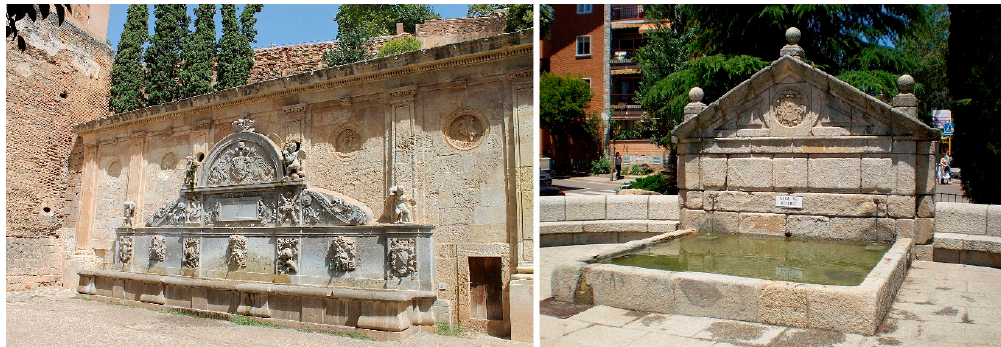
Figure 2. To the left is the Pilar de Carlos V, Pedro de Machuca, 1545, Alhambra in Granada. The photograph was provided by © Nicolas Vollmer CC-BY-2.0, via Wikimedia Commons. To the right is the Caño Fountain, 1591, Torrelodones (Madrid). The photograph was provided by © Esetena, CC-BY-SA-3.0, via Wikimedia Commons.